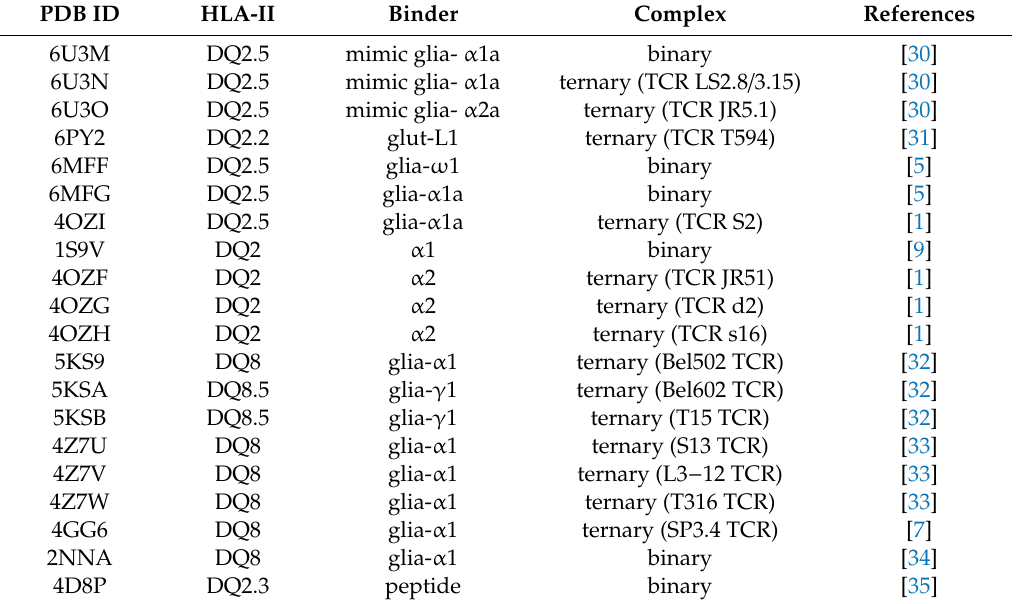
Table 1. The list of Protein Data Bank (PDB) structures of binary and ternary complexes involving human leucocyte antigen (HLA)DQ, gluten peptides and T-cell receptor (TCR) updated to October 2020.